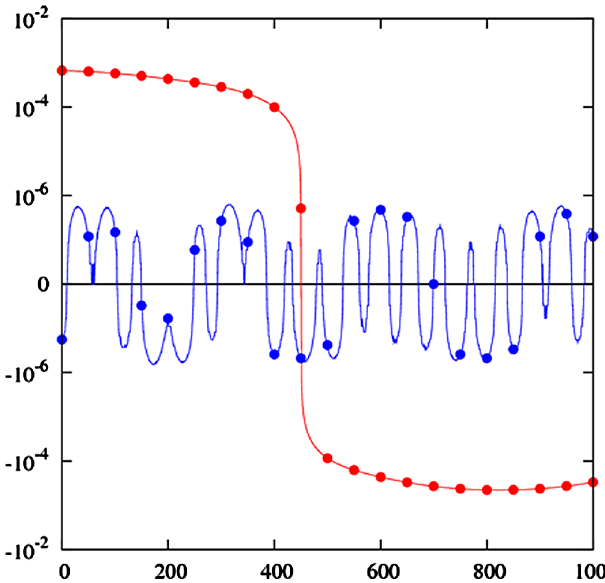
FIG. 3. Betatron tune deviation versus the window shift (in turns) for two trajectories: chaotic (red) and regular (blue).